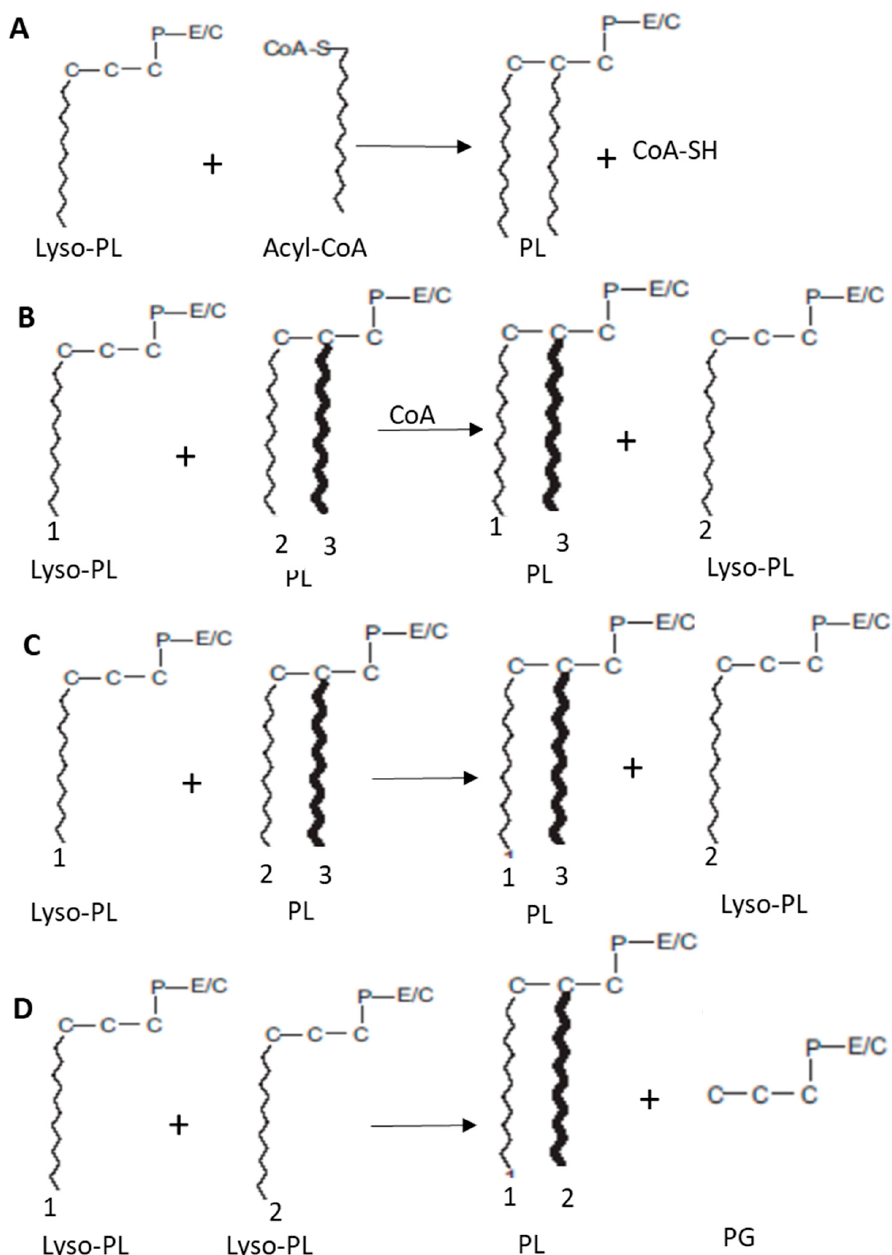
Figure 6. Remodeling of glycerophospholipids (E/C: ethanolamine/choline) [11]. Several